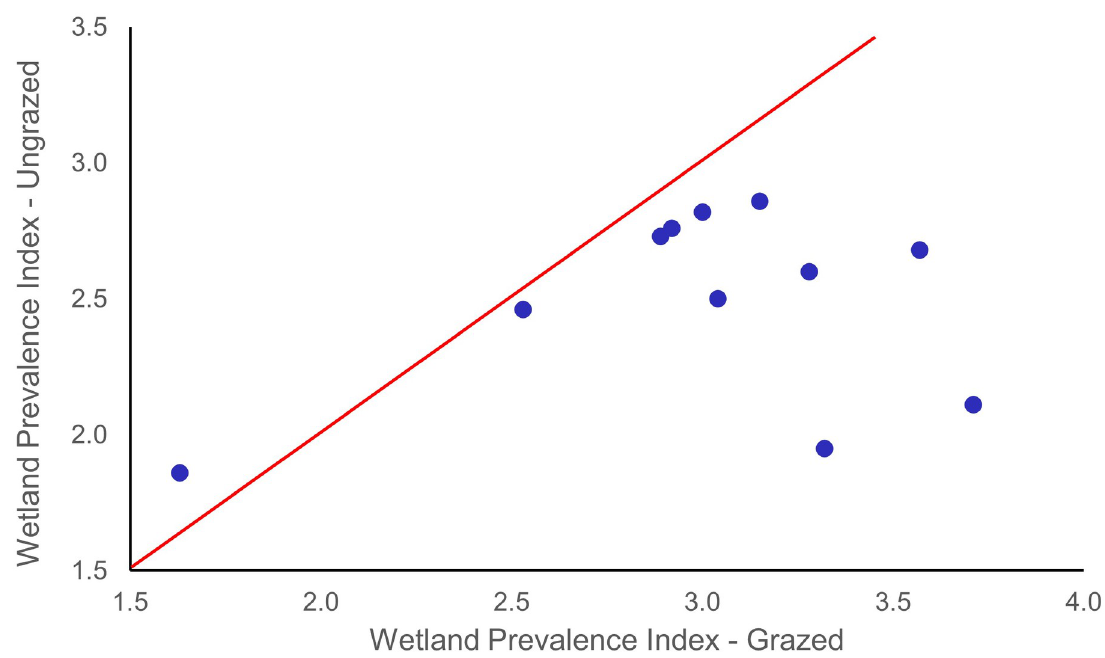
Fig 4. The relationship of the cover of an exotic grass, Kentucky bluegrass (P oa pratensis ) adapted to herbivory, within 11 paired grazed and ungrazed riparian reaches in northeastern Oregon. If there was no difference in the abundance of this species between grazed and exclosed areas the data points would be expected to fall on or near the line. Data points below the line indicates a lower abundance of P . pratensis in ungrazed reaches compared to grazed reaches. The abundance of Kentucky bluegrass in was significantly less (p = 0.03) in ungrazed